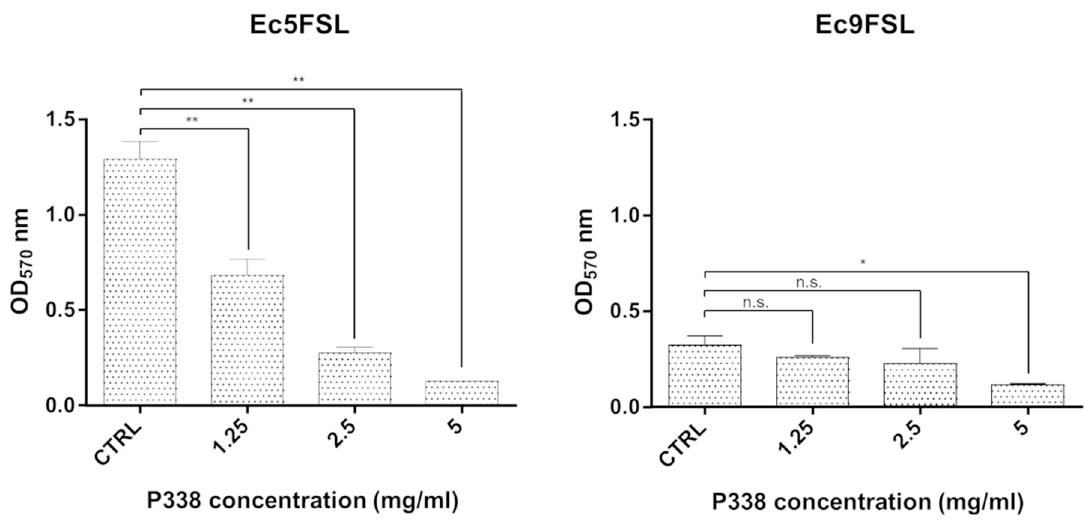
Figure 1. Different P338 concentrations reduce the biofilm biomass of E. coli isolates in static conditions: OD 570 values of CV-stained Ec5FSL and Ec9FSL untreated biofilms (CTRL) treated for 6 h with different P338 concentrations. The results are shown as the mean ± standard deviation of the values obtained from three independent experiments under each condition; * p -value < 0.05 (confi-